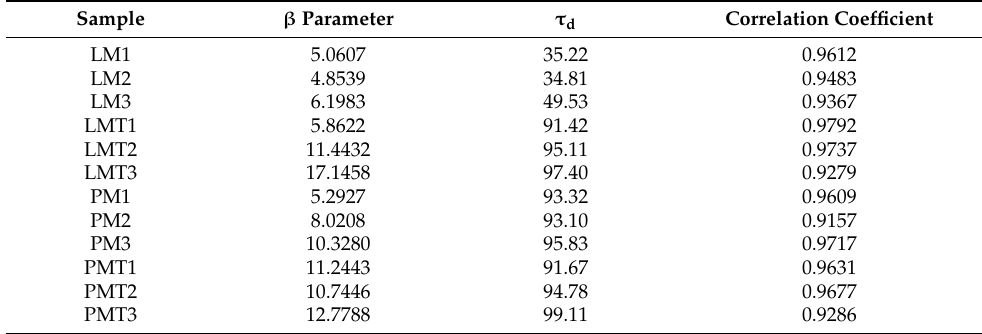
Table 3. Dissolution kinetic parameters of Melatonin-loaded PLA and PVA nanofibers.